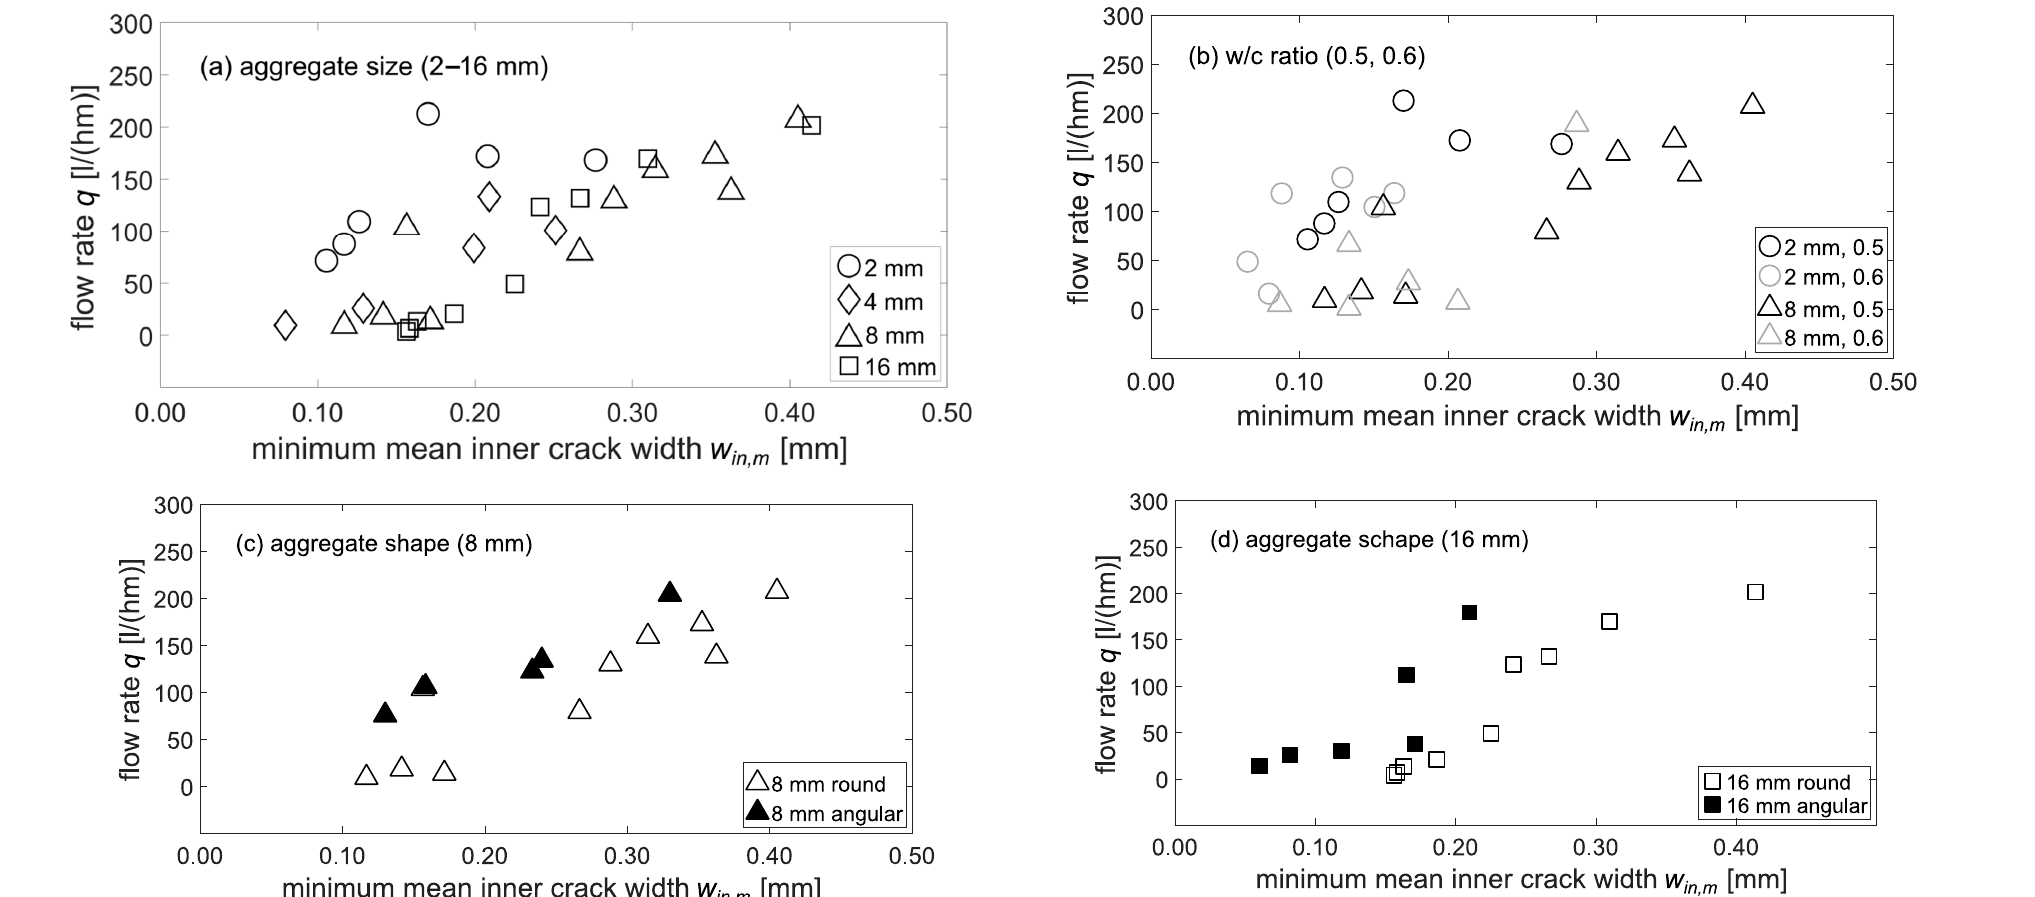
Figure 16. Effect of minimum mean inner-crack width min. mean w in,m on flow rate q in dependence of ( a ) Aggregate size (2–16 mm, round, w / c : 0.5); ( b ) v-ratio (round), ( c ) Aggregate shape 8 mm ( w / c : 0.5), ( d ) Aggregate shape 16 mm ( w / c : 0.5). All concrete mixtures shown here were made with a coarse sieve curve and ordinary Portland cement; (µCT voxel edge length: 58.2 µm).